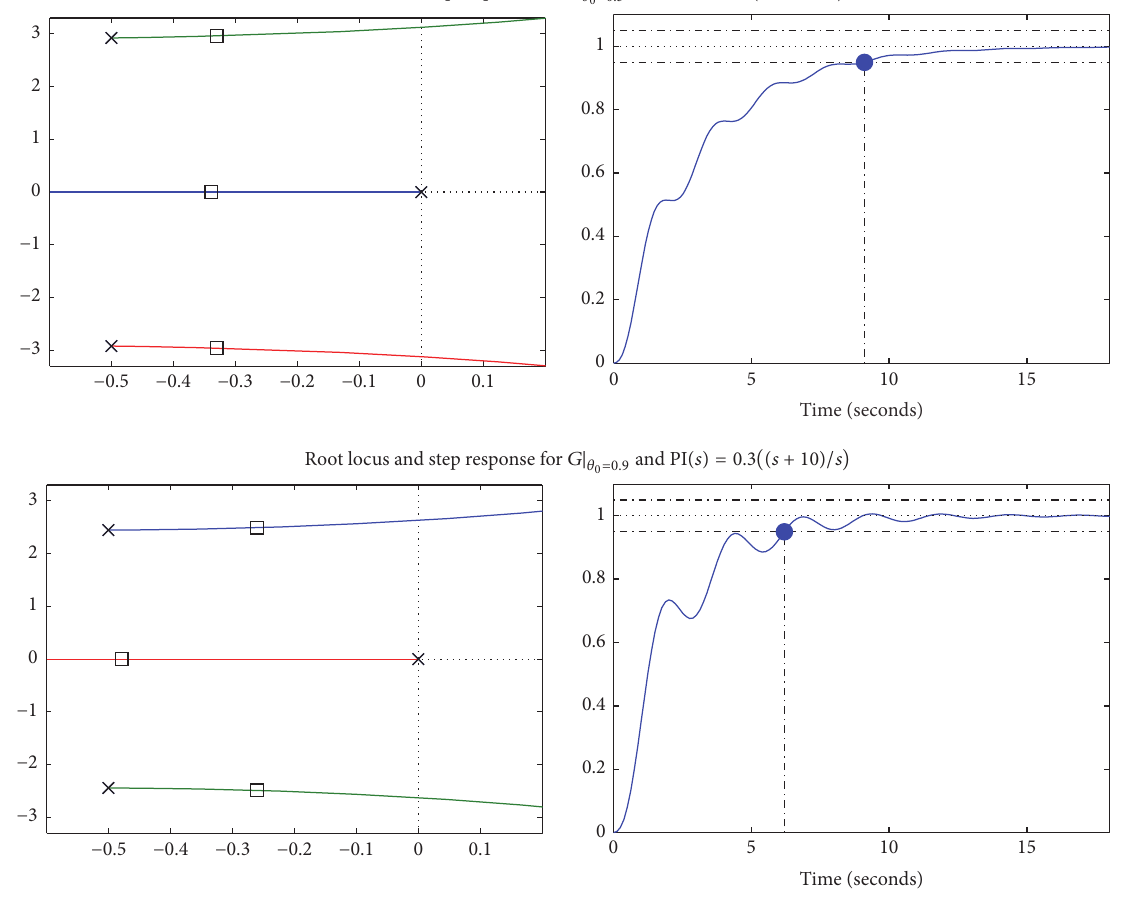
Figure 9: PI control at two different linearization